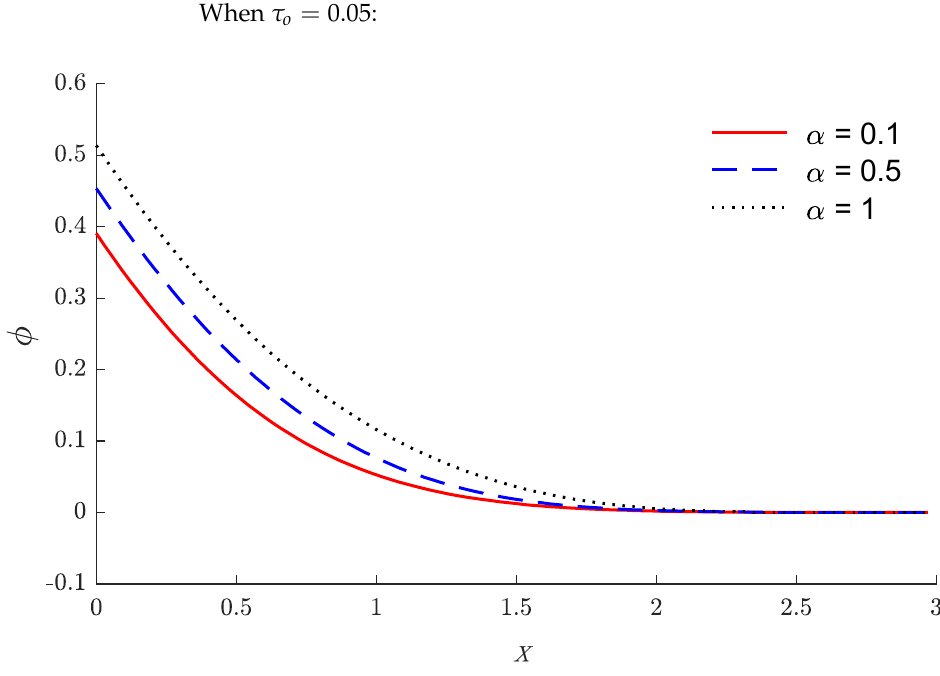
Figure 2. The electric potential distribution via the distance x for three values of fractional parameters. When τ o = 0.05 :